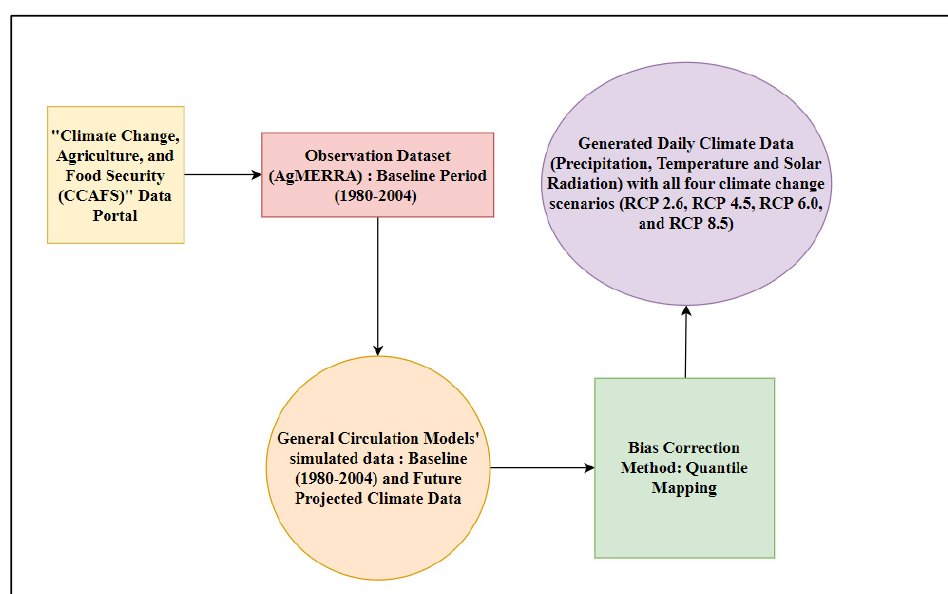
Figure 2. Flowchart for obtaining and processing of the climate data.